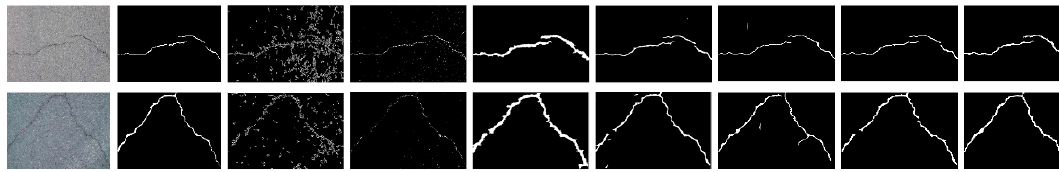
Figure 7. Results of comparison of proposed U-HDN with other method based on public database (From left to right: input image, ground truth, Canny, local threshold, CrackForest, structured prediction, U-net, ensemble network, and proposed U-HDN).